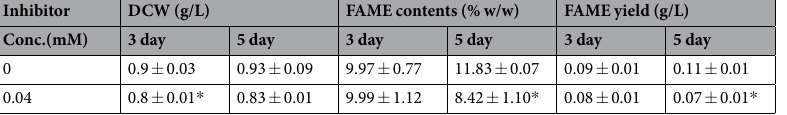
Table 2. Total dry cell weight, lipid contents, and lipid yields of C.reinhardtii grown under various concentrations of the MEK inhibitor pd98059. Data are expressed as mean ± SD (n = 3). Significant differences, as determined by Student’s t-test, are indicated by an asterisk ( * P < 0.05, ** P < 0.01, *** P <